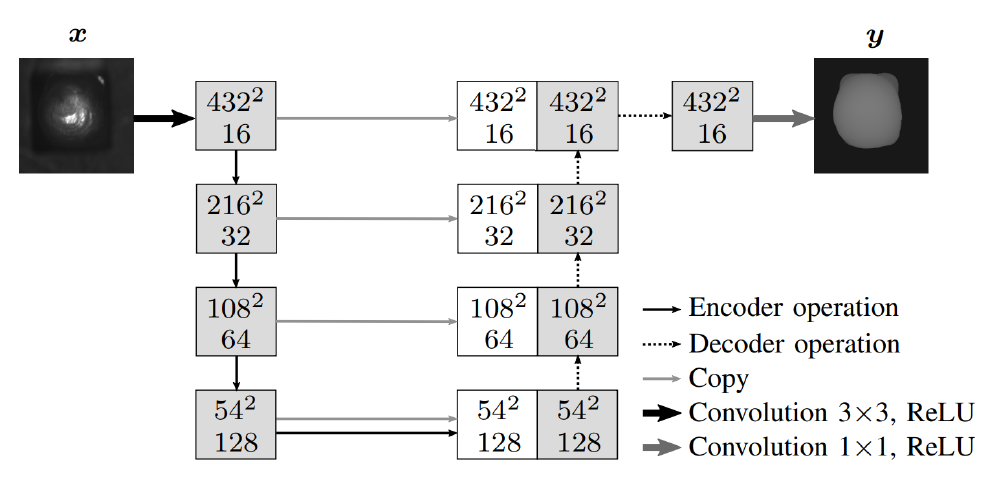
Figure 3. U-Net structure for 3D reconstruction. Input is the 2D gray-scale image of a hairpin x ; output is the 3D reconstruction y . Boxes represent feature maps, where the first number indicates the spatial dimension and the second the number of channels. White boxes represent copied feature maps, which are linked to the decoder maps in the expanding